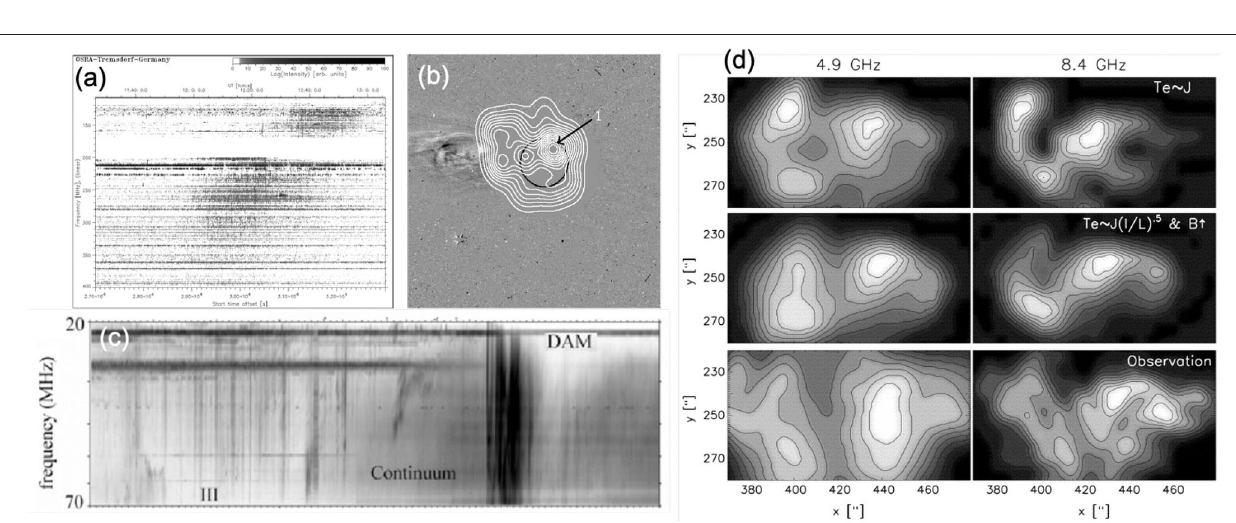
FIGURE 2 | (a) Astrophysical Institute Potsdam spectra showing the faint type IV continuum on May 16 (from Aurass et al., 1999). (b) Composite of the GRH 109 MHz radioheliogram (white contours) at 05:00 UT and the SOHO-LASCO C2 image at 05:19 UT on 2010 January 15 showing the CME and Type-I noise storm (from Ramesh et al., 2012b). (c) DAM radio spectrum of an outburst following type-III emissions and a continuum increase (from Pick et al., 2005). (d) Comparison of model (top two rows) and observed (bottom row) radio intensities at 4.9 and 8.4 GHz (left and right panels, resp.). The key assumption for the dependence of electron temperature to currents is shown at the upper right-hand corner of the right panels. The comparison demonstrates the power of multi-frequency observations in constraining coronal magnetic properties (from Lee et al., 1998). All figures reproduced by permission of the